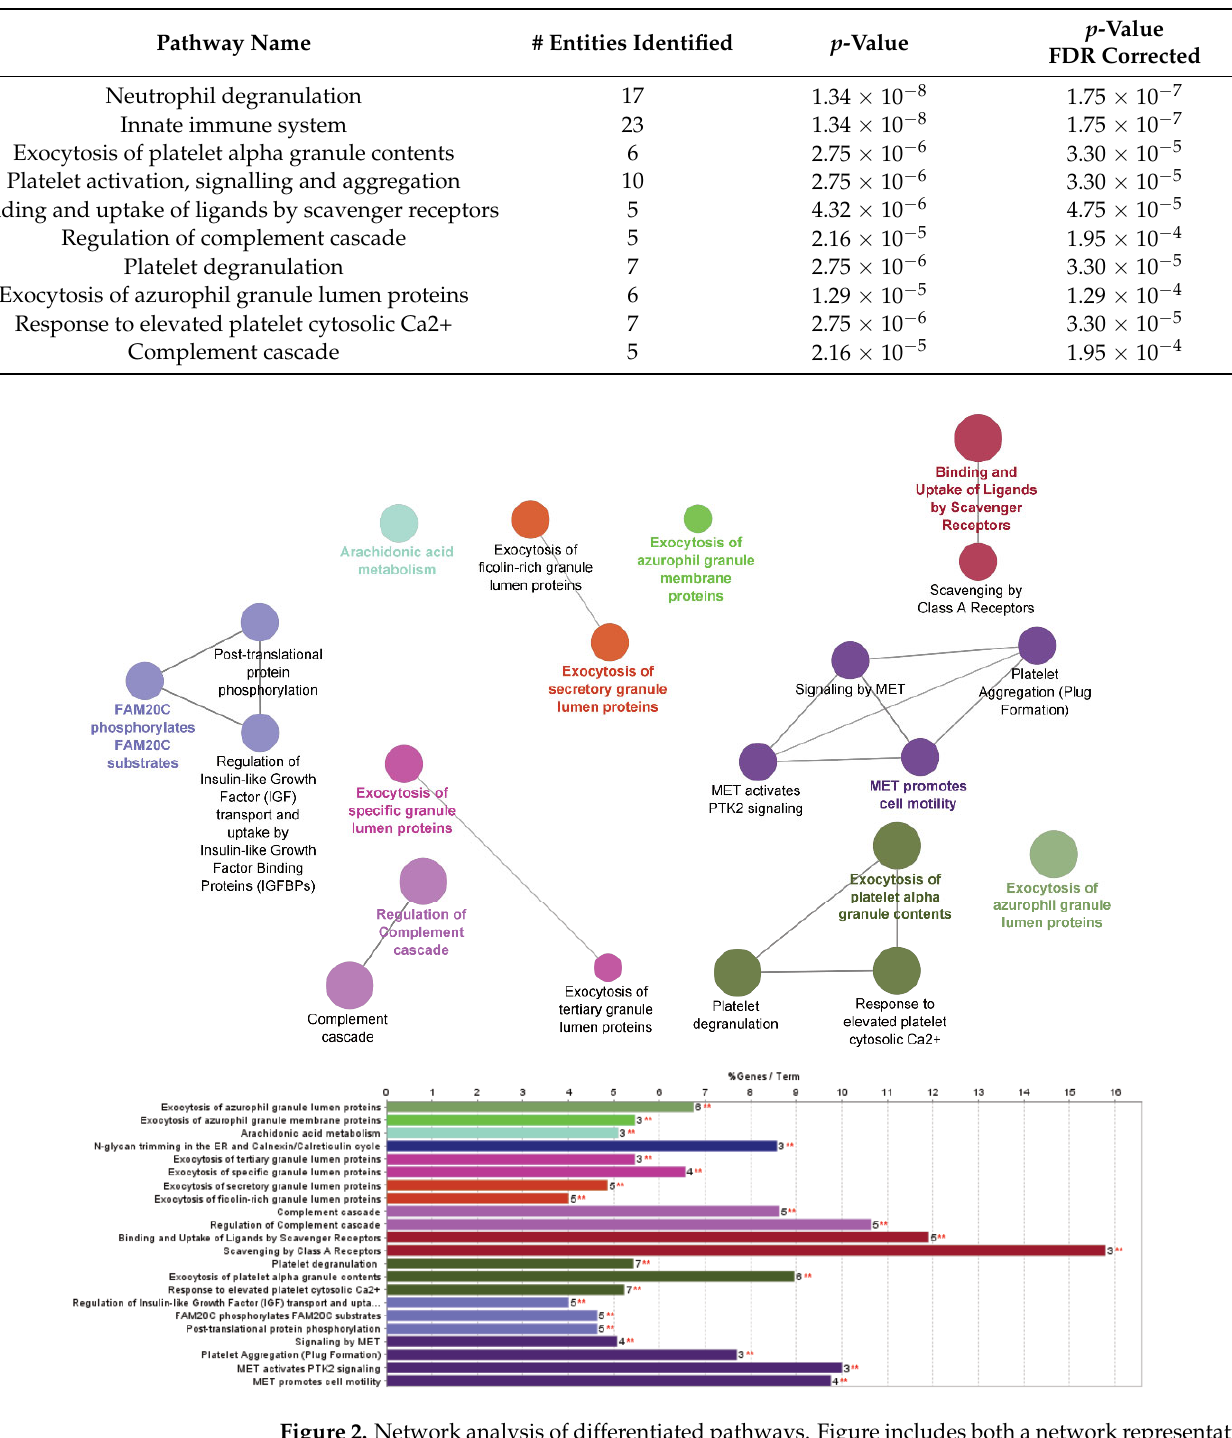
Figure 2. Network analysis of differentiated pathways. Figure includes both a network representation of pathways differentiated between COVID-19-positive participants treated with glucocorticoids and those not treated with glucocorticoids, together with the number of pathways altered (bottom chart) and false-discovery corrected statistical significance, ** indicates p ≤ 0.01 generated in CytoScape with ClueGO. Links between nodes are presented for readability and are not proportional to significance or impact.